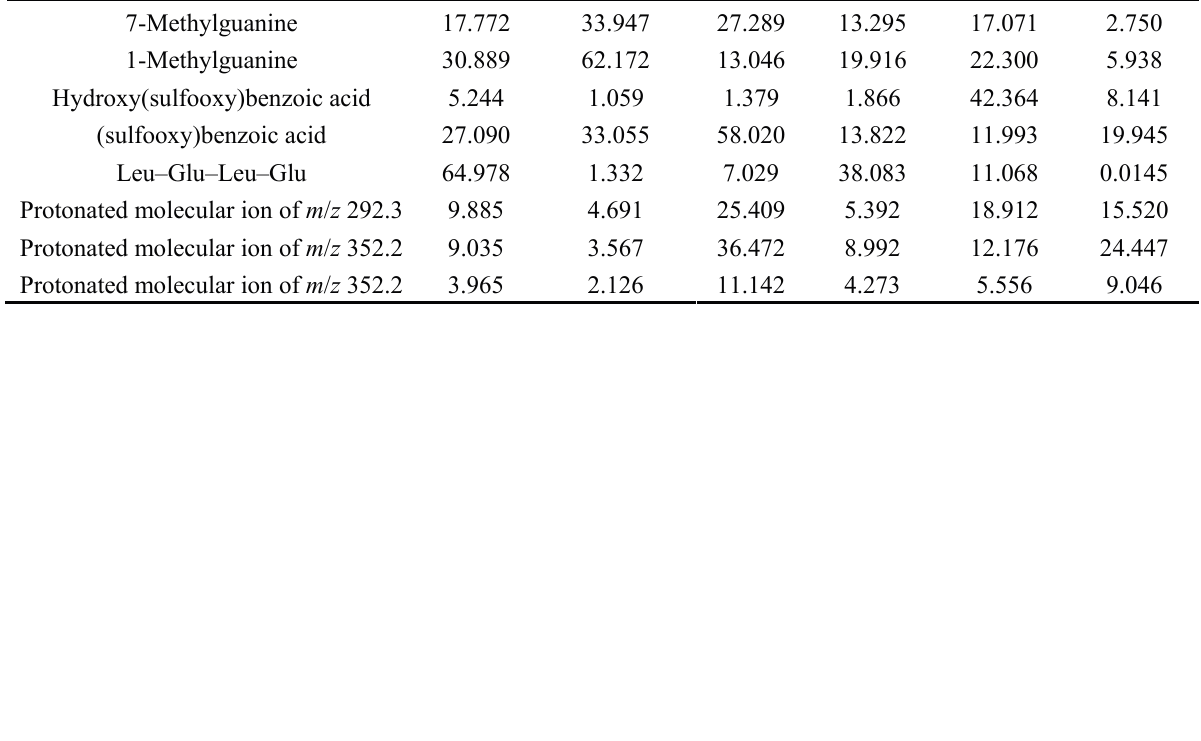
Table A1. Median of the relative abundance of metabolites produced in Aspergillus species.